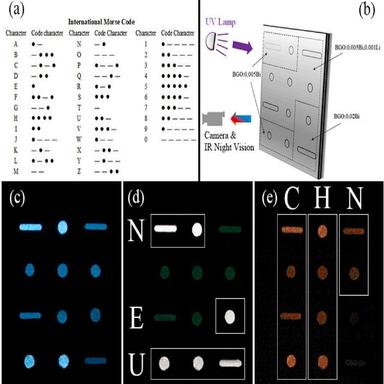
(a) Table of International Morse Code and (b) schematic diagram of the designed logos. (c,d) are the (c) appearances of the designed logos under 254-nm radiation, (d) afterglow signals of the designed logos observed by naked eye after removal of 254-nm irradiation. (e) is afterglow signals of the designed logos observed by a night vision device.